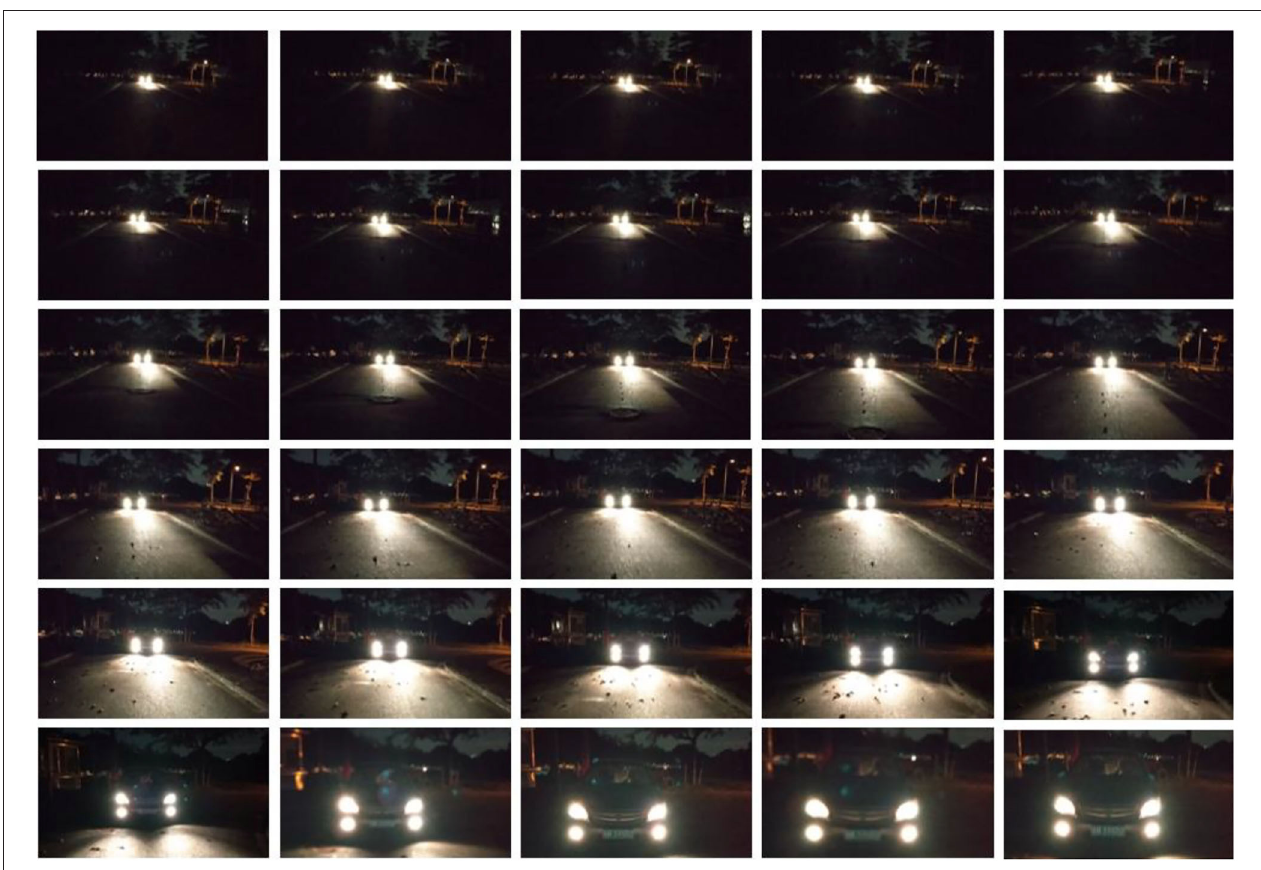
FIGURE 9 | Diagram of the dynamic change process of low beam headlights from far to near.